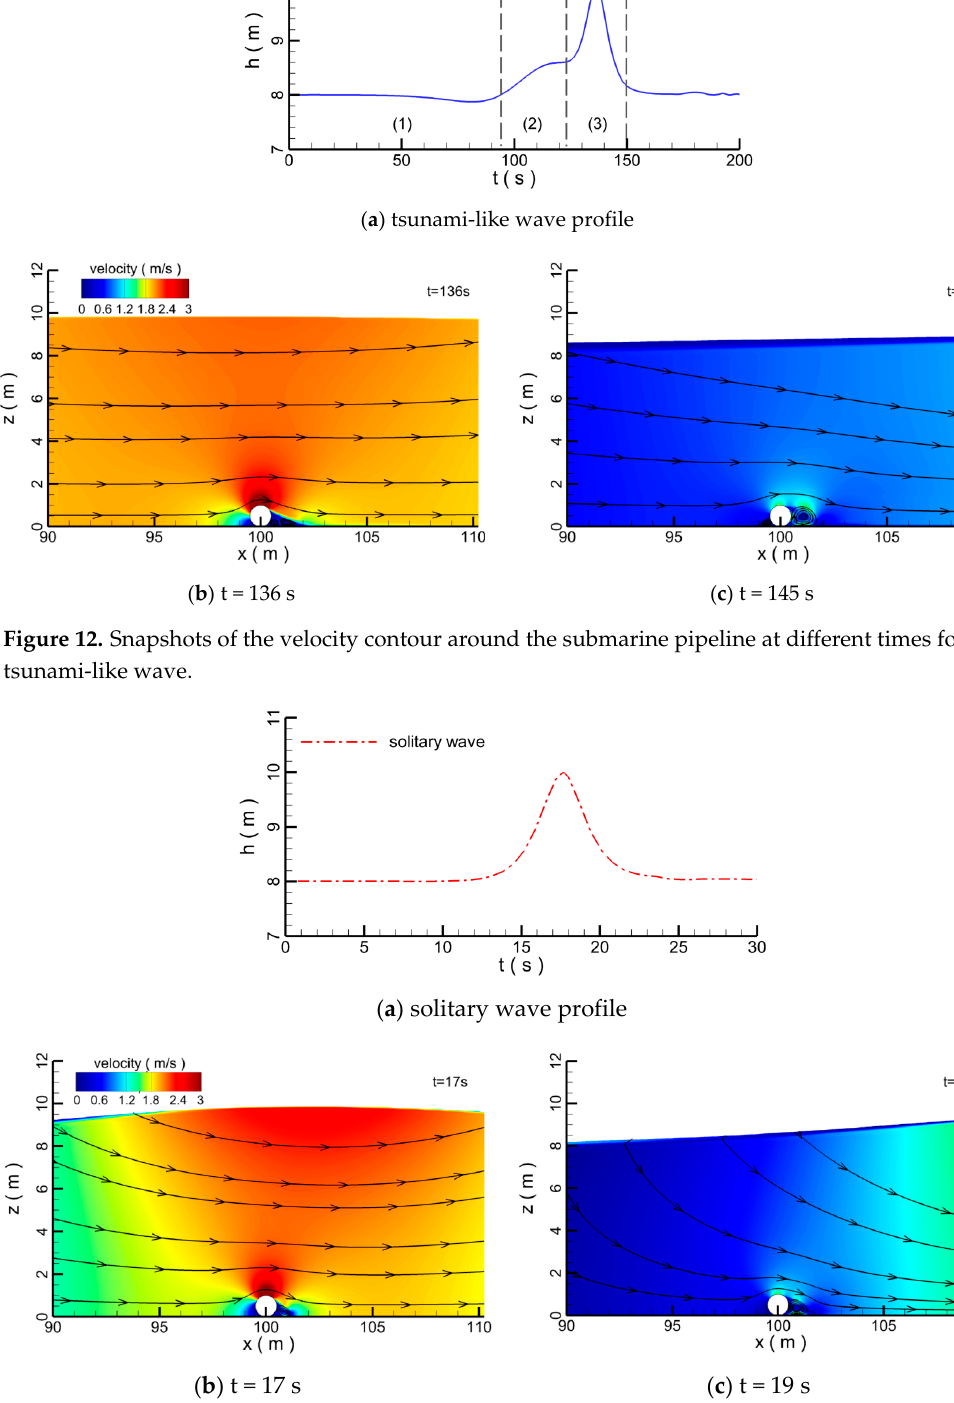
Figure 13. Snapshots of the velocity contour around submarine pipeline at different times for the solitary wave.